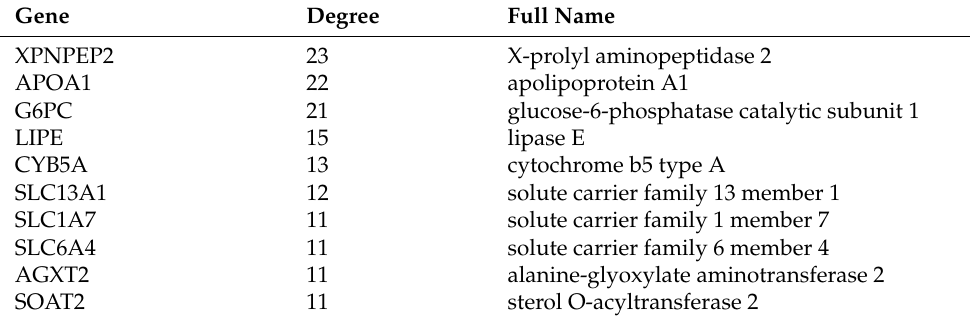
Table 1. Information of 10 hub